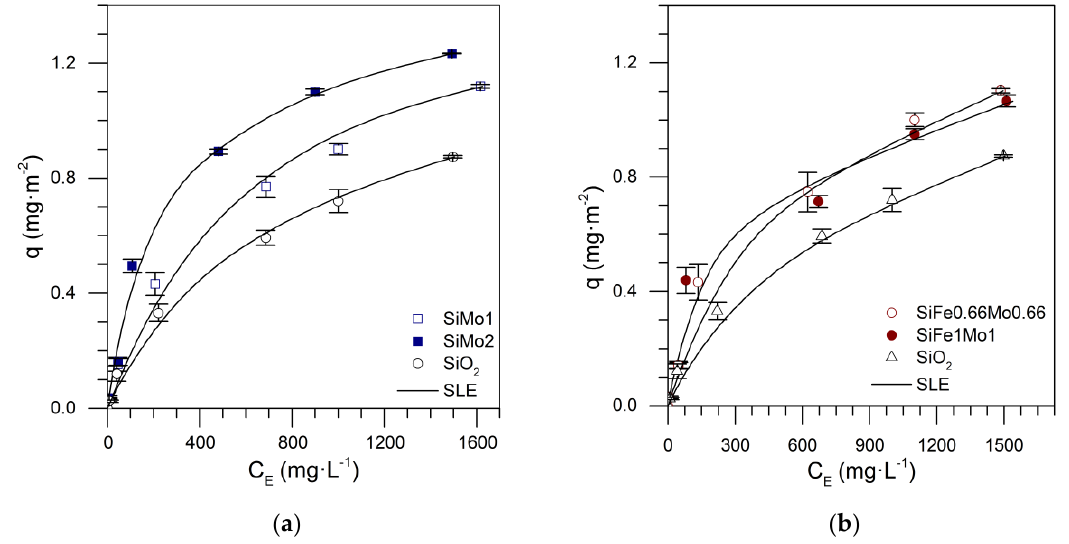
Figure 8. Asphaltene adsorption isotherms for nanoparticles ( a ) SiO 2 , SiMo1, SiMo2, ( b ) SiO 2 , SiFe1Mo1, and SiFe0.66Mo0.66 at 25 °C. The symbols are experimental data, and the solid lines are SLE model data.